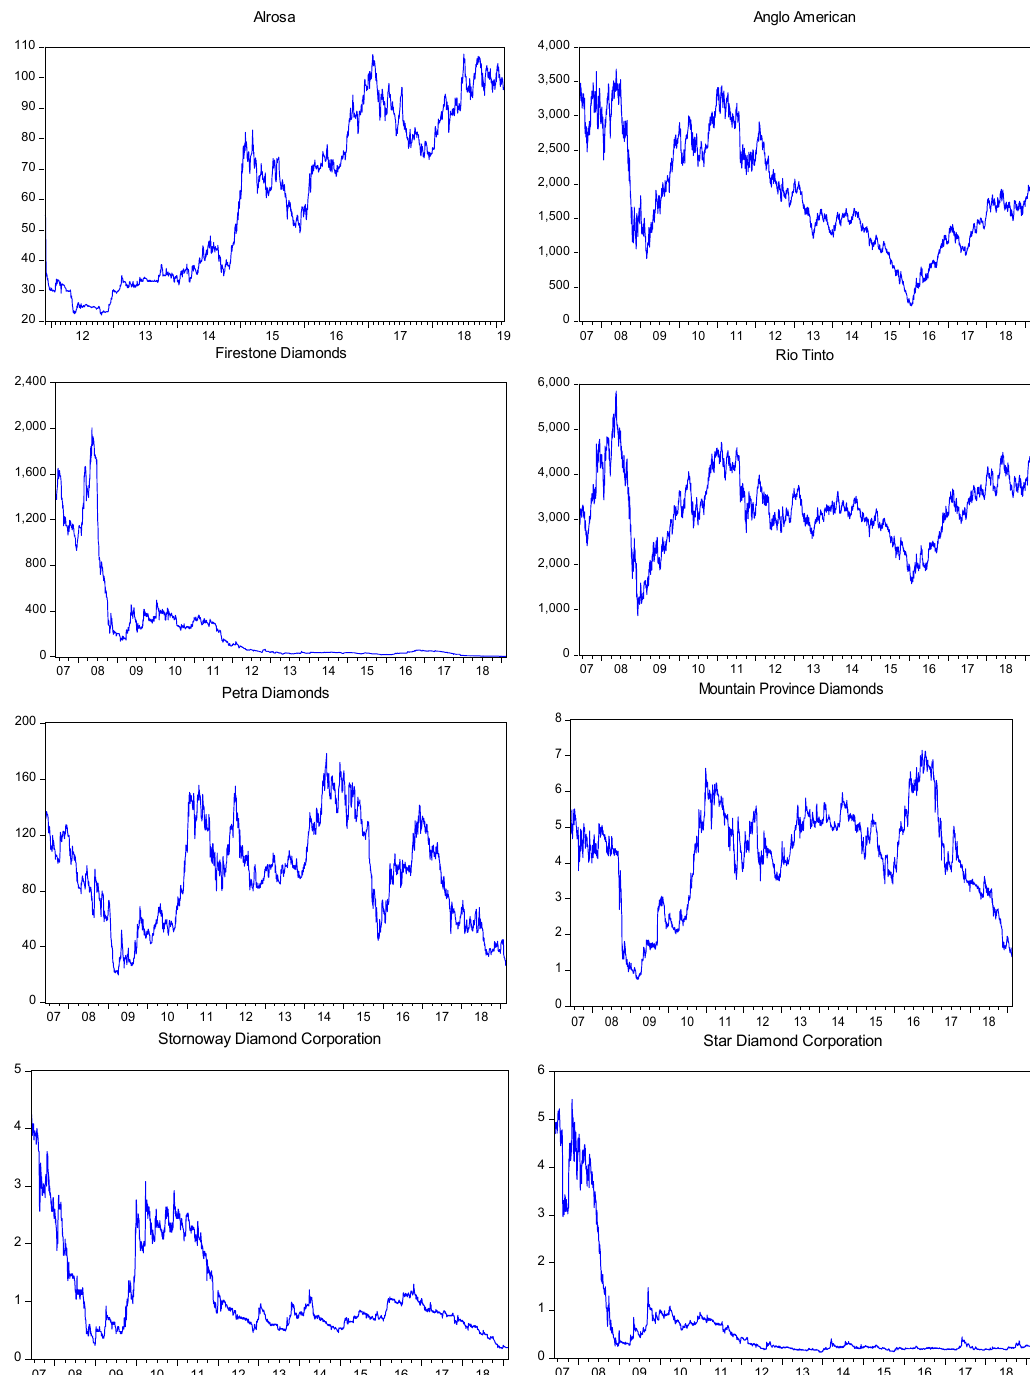
Figure 6. Price dynamics of diamond stocks. Notes: Price dynamics of 8 diamond stocks included in the analysis sub-sample in their original currencies for the period 4 June 2007–15 February 2019: Alrosa (RUB), Anglo American (GBP), Firestone Diamonds (GBP), Rio Tinto (GBP), Petra Diamonds (GBP), Mountain Province Diamonds (CAD), Stornoway Diamond Corporation (CAD) and Star Diamond Corporation (CAD). Alrosa is only listed in 2011. Source : Elaboration on Bloomberg and Yahoo Finance